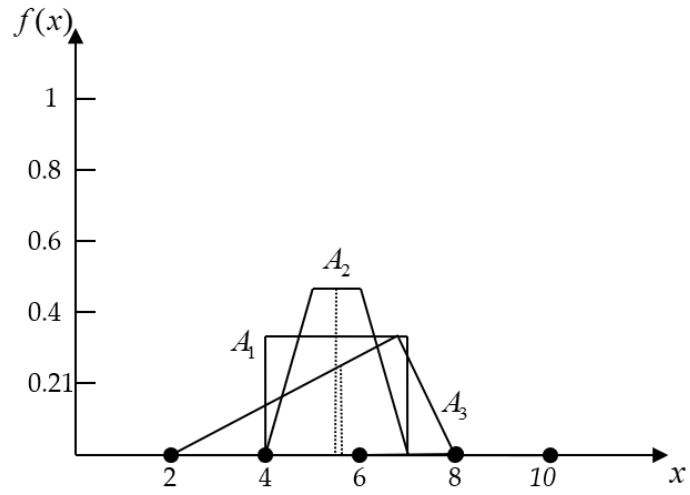
Figure 5. The probability density function in the third example.